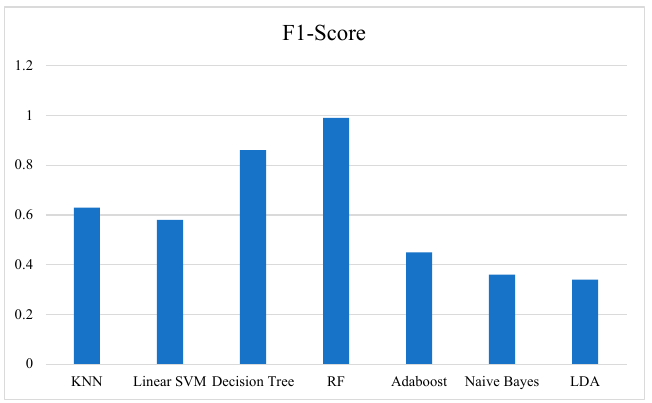
Figure A9. F1-score machine learning algorithm model balance score comparison.